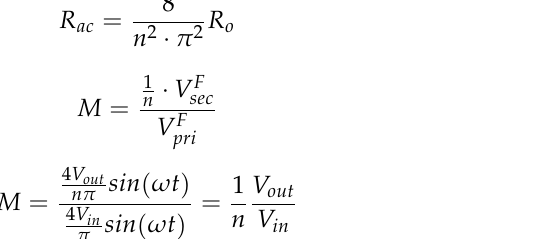
These resonance tank components can be expressed as